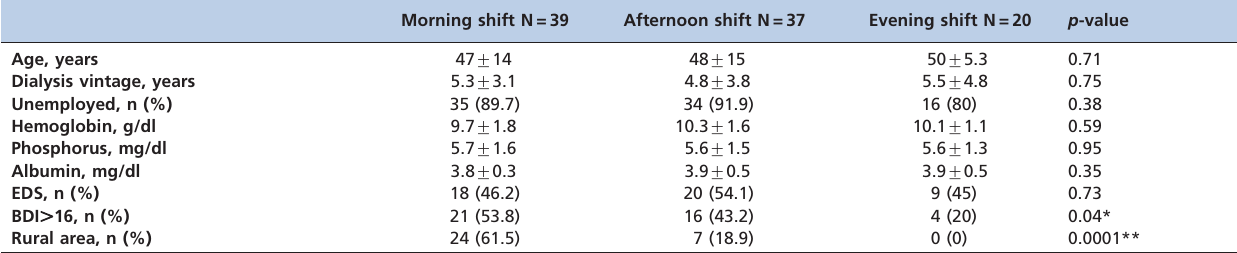
Table 2 - Variables among dialysis shifts.